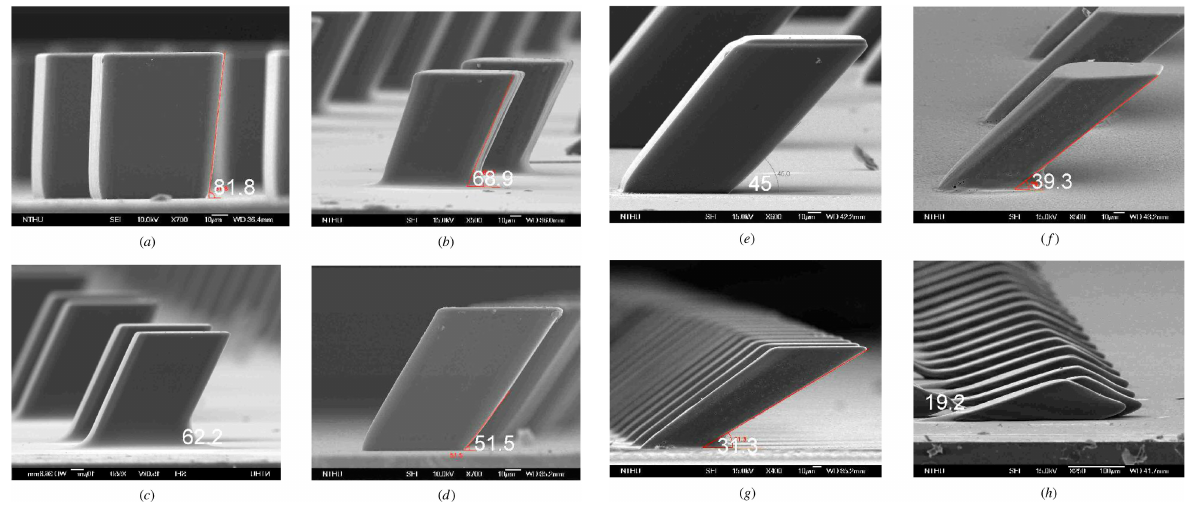
Figure 3. SEM images of the fabricated inclined SU-8 pillars with various angles. Reprinted with permission from [20], copyright 2004 Institute of